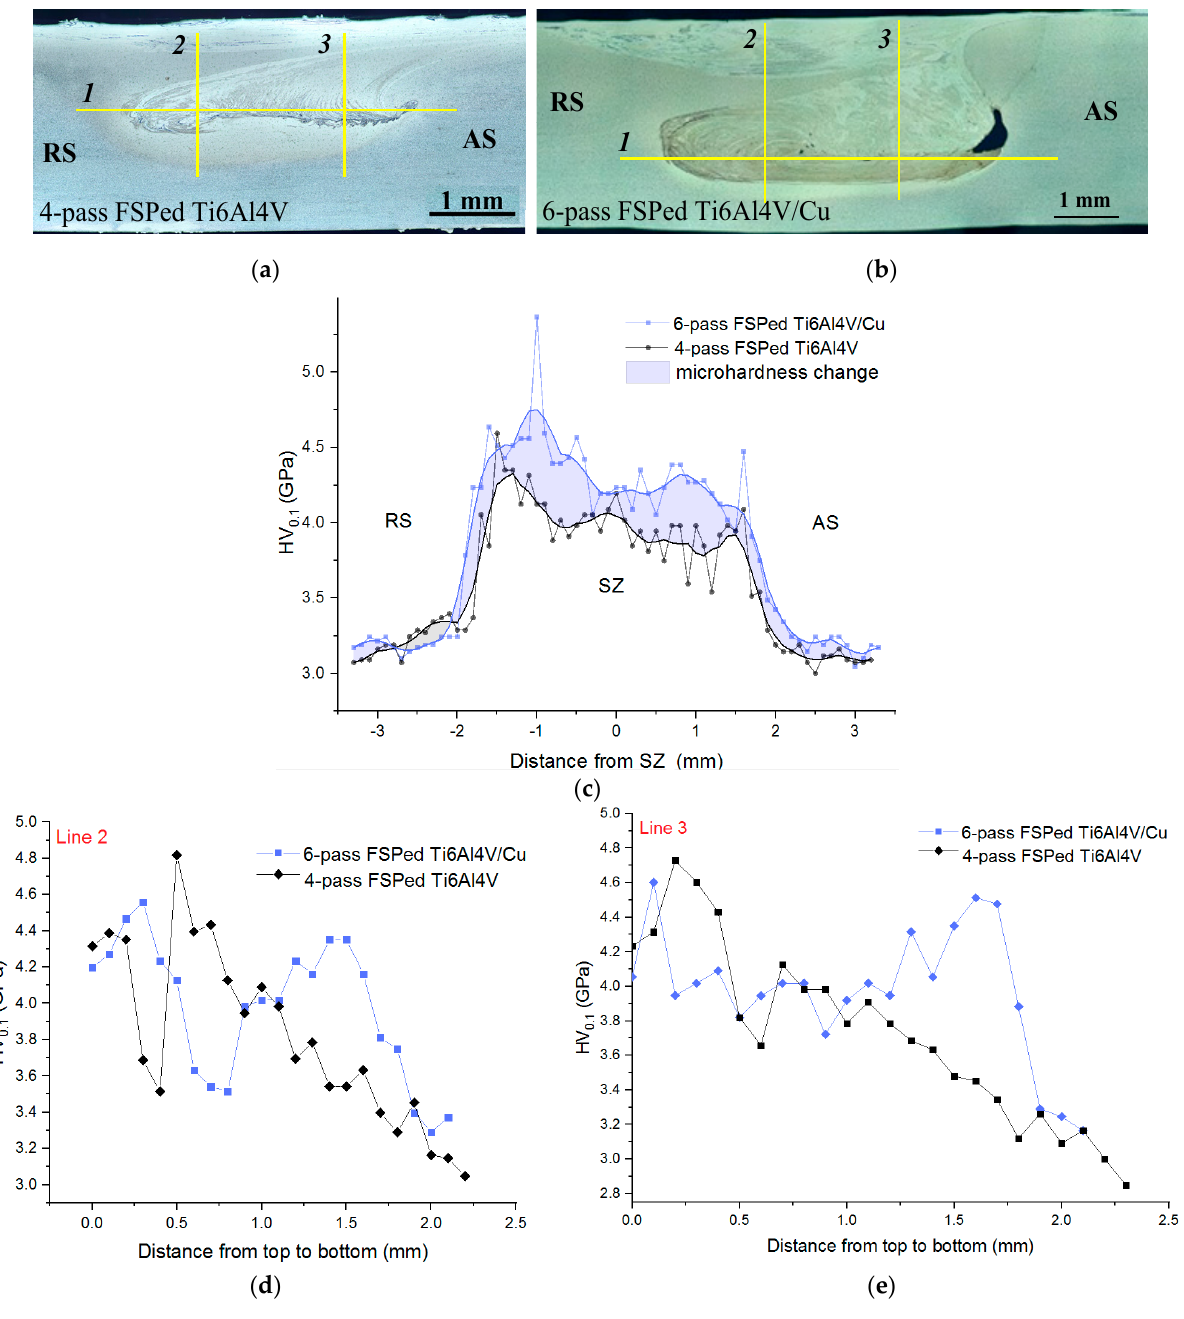
Figure 13. Microhardness profile measurement lines ( a , b ) and microhardness profiles along the horizontal (line 1) ( c ) and vertical (lines 2 and 3) directions ( d , e ). The corresponding profiles obtained from indenting along the vertical lines 2 and 3 showed almost the same microhardness levels above the horizontal lines 1 in Figure 13a,b, while the microhardness profiles measured along the downward portions of both lines 2 and 3 showed 15% higher hardness for the Ti6Al4V/Cu SZ (Figure 13d,e). All the vertical profiles related to the four-pass FSPed Ti6Al4V demonstrated the microhardness reduc- tion, as measured in the direction from the SZ top to bottom. Analogous profiles from the Ti6Al4V/Cu SZ showed the enhanced microhardness peaks below the horizontal line 1,